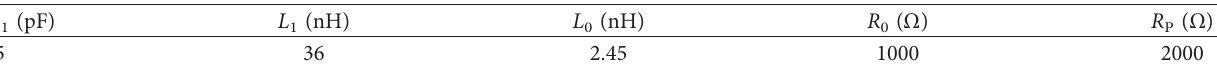
Figure 5: Fabrication of reflection phase shifter. Table 1: The values of the components.